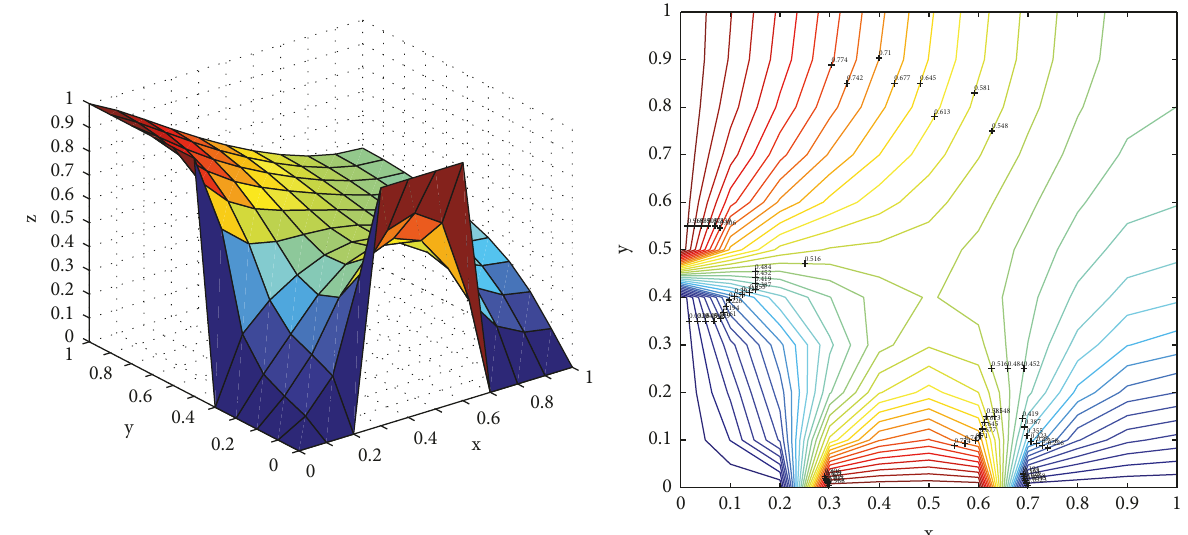
Figure 3: Pollutant distribution in a street tunnel with advection in 𝑥 and 𝑦 directions.